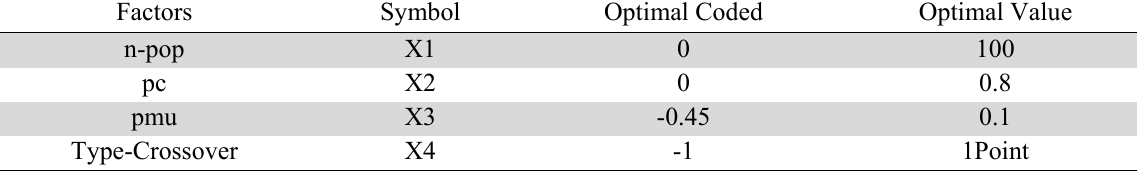
The input parameters for the implementation of NSGA II